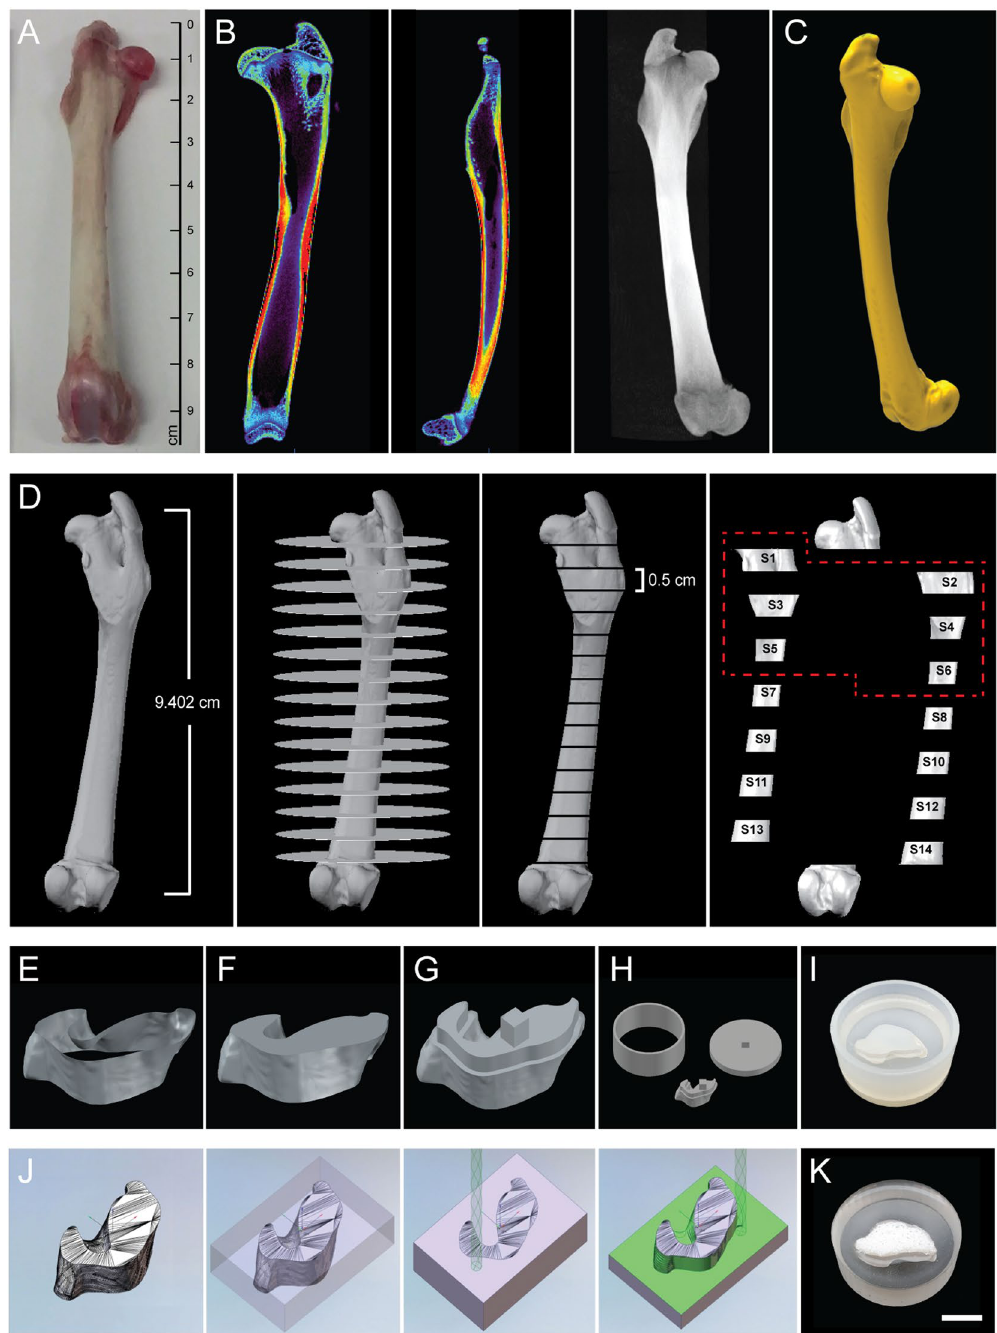
Figure 2. Partitioning of bone defect reconstructions and manufacturing of perfusion inserts and scaffolds for culture in bioreactor. ( A ) Photograph of a rabbit femur (right leg). ( B ) Image data of the femur (virtual femur) visualized in ASIPro VM ™ (front view, side view and 3D) ( C ) 3D model of the virtual femur as reconstructed in Simpleware. ( D ) Partition of the rabbit femur into 14 virtual segments (S1-S14) with discoidal geometry and defined thickness (0.5 cm each). Only the first six virtual segments were used for SATE (red dashed line) ( E ) View of virtual segment 1 generated from partitioning of the digital model of the rabbit femur. ( F ) Patched segment 1. ( G ) Segment 1 reshaped in AutoCAD to include an offset and a plug for the construction of an equilibration chamber within the perfusion insert. ( H ) Digital representation of a three-part mold for casting the perfusion insert corresponding to segment 1. ( I ) Assembled 3D printed mold filled with PDMS for the construction of the perfusion insert corresponding to segment 1. ( J ) Simulation of the milling process for the construction of a customized scaffold corresponding to virtual segment 1. ( K ) 5-axis milled decellularized bone scaffold corresponding to segment 1 placed inside its respective perfusion insert. Abbreviations: 3D, three- dimensional; S, segment; PDMS, polydimethylsiloxane. Additional data are shown in Video S2, Figs S1, S2, S3, S4, S5 and